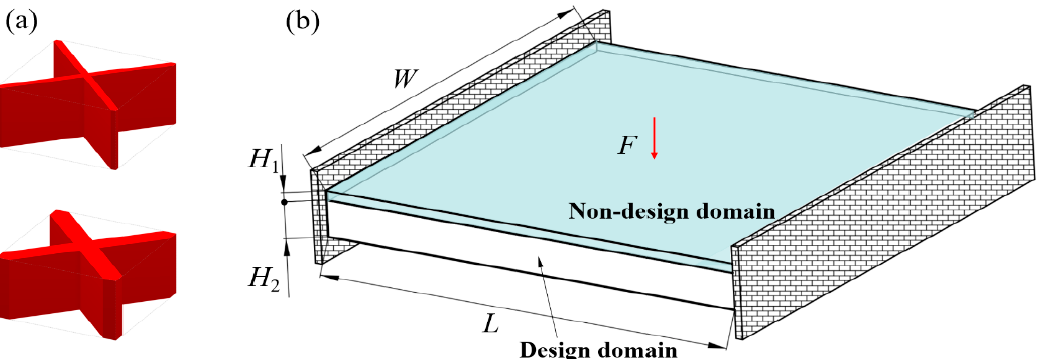
Figure 8. Pre-defined unit cells and design domain of TWSS. ( a ) X-shaped stiffening rib unit cells with different volume fractions. ( b ) Loading and boundary conditions for 3D TWSS.